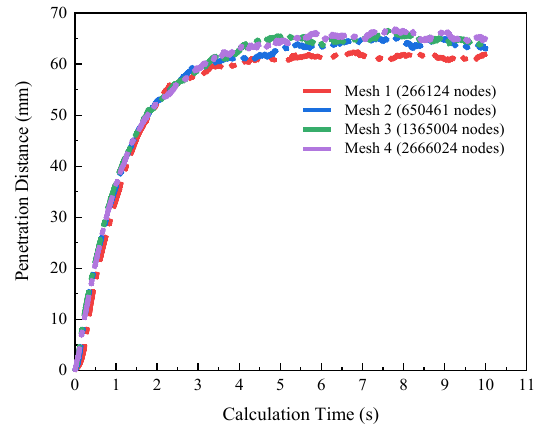
Figure 2. Spray tip penetration for various grid sizes.